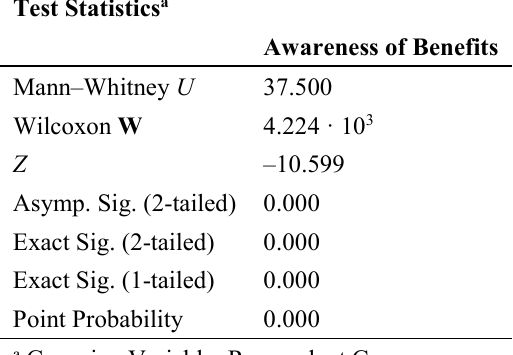
Table 4. Result of Mann–Whitney U Test for Significance of